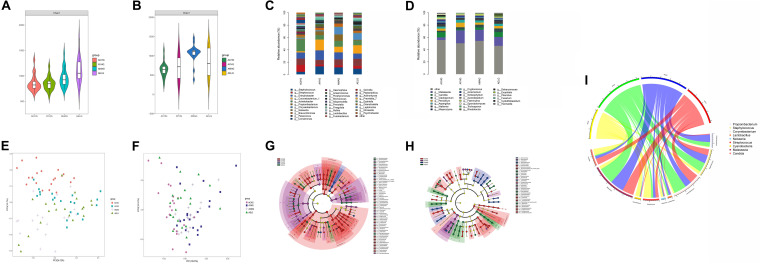
Variation in patterns of skin microbiome during the intrinsic aging process. Bacterial (A) and fungal (B) species richness at each age group. Relative abundances of bacterial (C) and fungal (D) core species at the genus level in each group. Weighted UniFrac-PCoA plots of skin bacteria (E) and fungi (F) in each group. Bacterial (G) and fungal (H) phylogenetic distributions during intrinsic skin aging (LDA score > 3, P-value < 0.05). Based on linear discriminant analysis effect size (LEfSe), the phylogenetic distributions of distinct taxa are colored corresponding to the different classification (phyla to species were depicted by circles from the inside to outside). Circlize analysis shows the relative abundances of nine unique age-related functional taxa in each age group (I).